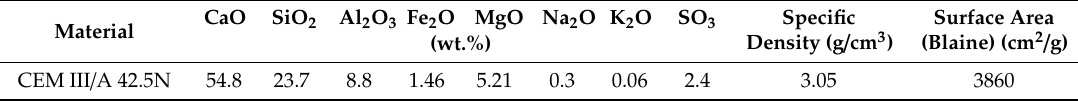
Table 1. Chemical and physical characteristics of cement.